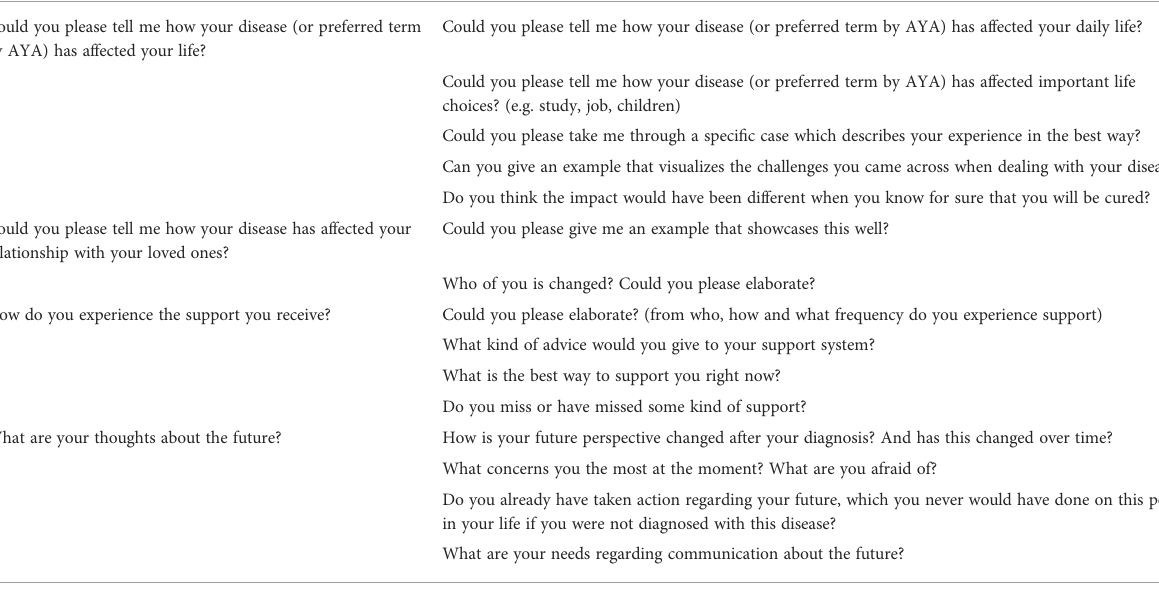
TABLE 1 Interview topic